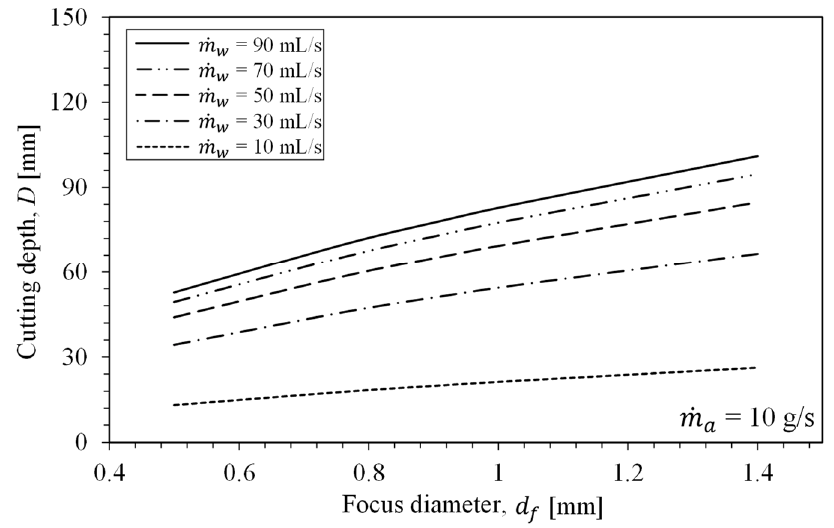
Figure 12. Effect of the focus diameter on the cutting depth owing to WFR.